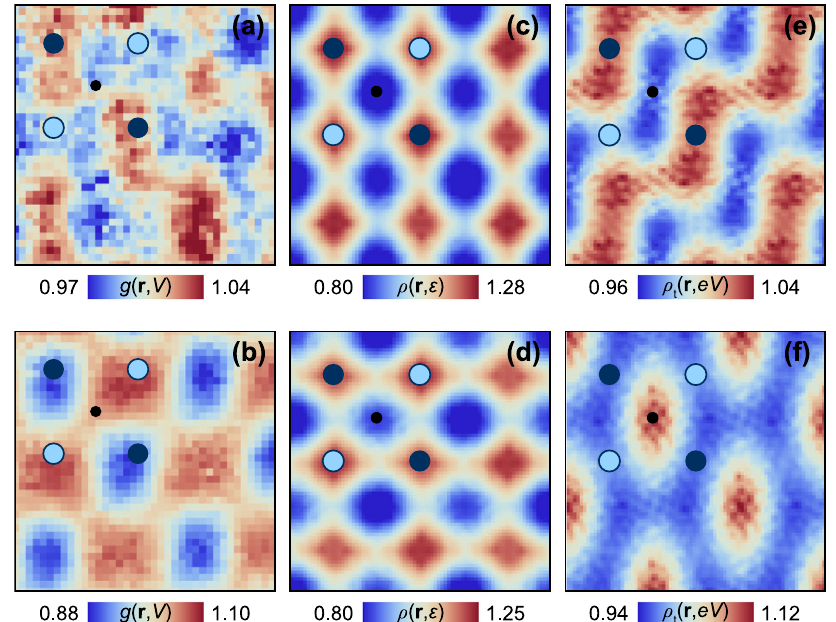
Fig. 4 Checkerboard charge order. a , b Experimental differential conductance maps g ( r , V ) taken at the energy of the vHs 22 at ( a ) positive energy, V = 3.5 mV and ( b ) negative energy, V = − 3.5 mV at which the checkerboard order is most prominent ( T = 59 mK, V set = 7.0 mV, I set = 250 pA, V L = 495 μ V, image size: 1.3 × 1.3 nm 2 ). c , d cLDOS ρ ( r , ε ) calculated at a height z = 5 above the surface at ( c ) ε = 5meV and ( d ) = 5 mV and ( f ) V = − 5 mV, emulating the effect of the feedback loop ε = − 5 meV. e , f Calculated differential conductance map ρ t ( r , eV ) at ( e ) V of the STM (see main text) for E set = 10 meV. The intensity of all images has been normalized by the spatial average, color bars indicate relative intensity. Filled dark and light blue circles mark the positions of Sr atoms, black- fi lled circles of the Ru atoms, as in Fig. 2c. For experimental details, see Methods